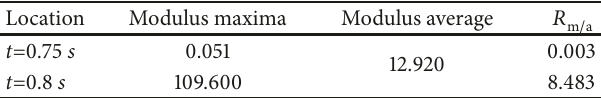
Table 2: 𝑅 m / a at the median point of the dislocation window and at